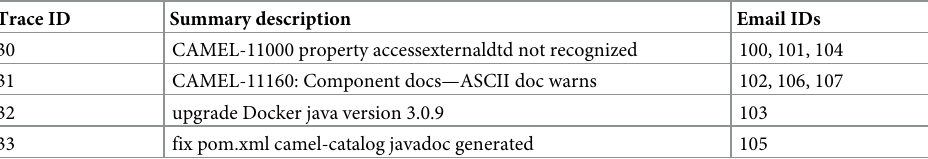
Table 4. Consensus trace descriptions for traces 30-33.